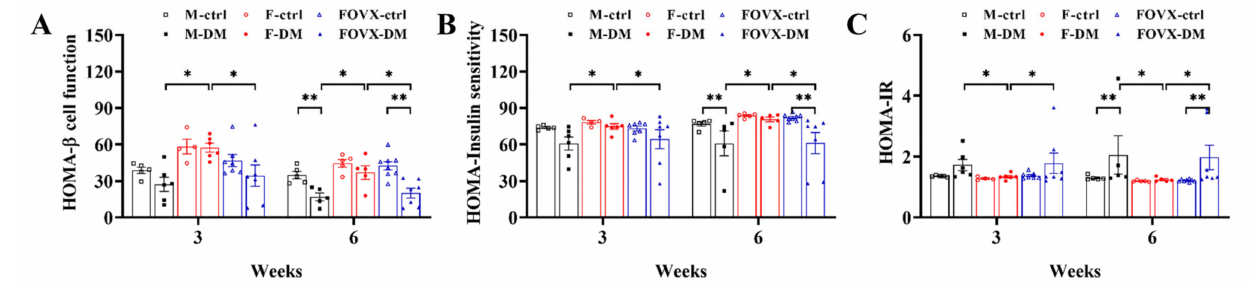
Figure 5. Changes in pancreatic beta-cell function (HOMA- β cell function) and insulin sensitivity (HOMA-Insulin sensitivity) in diabetic groups. Beta-cell function ( A ), insulin sensitivity ( B ), and HOMA-IR ( C ) were determined at 3 and 6 weeks using the public HOMA2 calculator. The beta-cell function of M-DM and FOVX-DM was significantly lower than that of F-DM. Data were analyzed using an independent two-sample t -test. * p < 0.05, ** p < 0.01 compared with the respective control